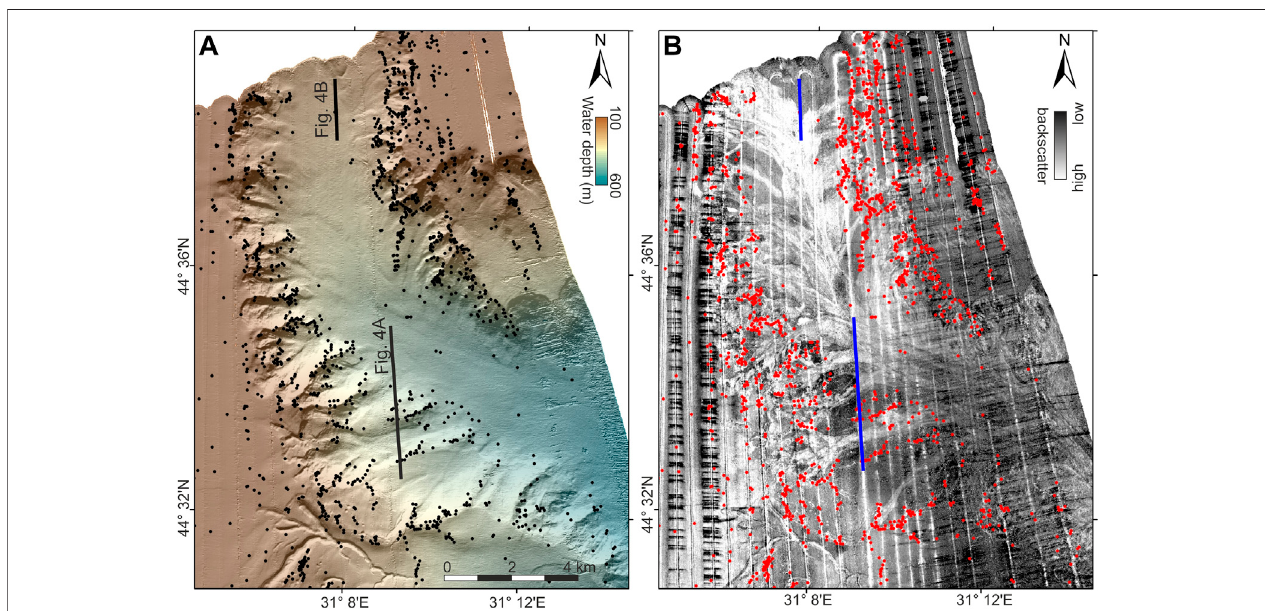
FIGURE 3 | Northern-most N1 canyon system, associated with the Dnepr river system. (A) Multibeam data with overlay of gas vent sites (black dots). (B) Sea fl oor backscatter with overlay of gas vents (red dots) highlighting individual chutes of mass-transport material removed from the canyon walls. These deposits overlap and merge in the talweg of the canyon. Gas seeps are tightly linked to the head-scarps and remaining ridges in the canyon walls. Two examples of sub-bottom pro fi ler data are given in Figure 4 . Poor weather conditions created the black-and-white striping pattern on some of the lines.